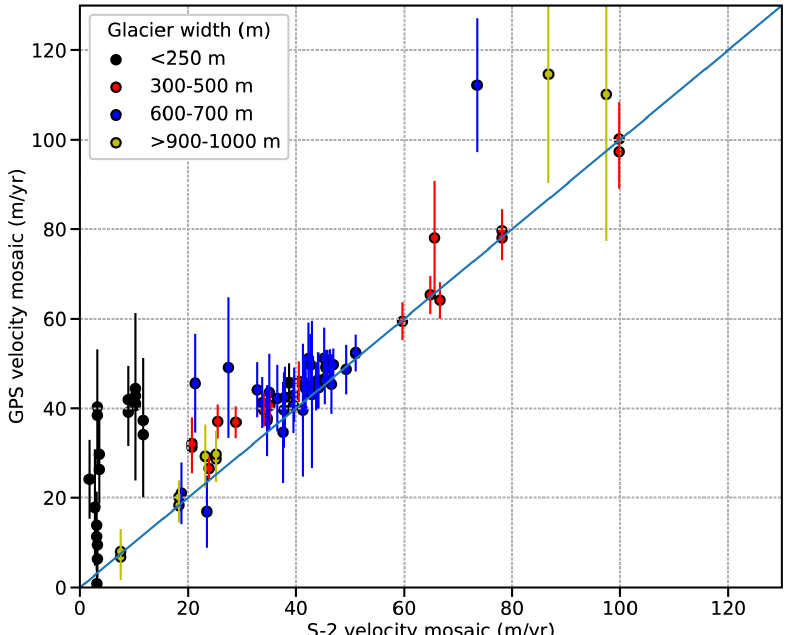
Figure 5. Comparison between satellite-derived and differential GPS glacier surface velocities between 2015 and 2018 from GLACIOCLIM database in the Mont-Blanc massif and from [18] in the Ötztal Alps. Displayed error bars are the local weighted standard deviation (1-sigma) as in Figure 2B. Data points are color-coded as a function of the glacier